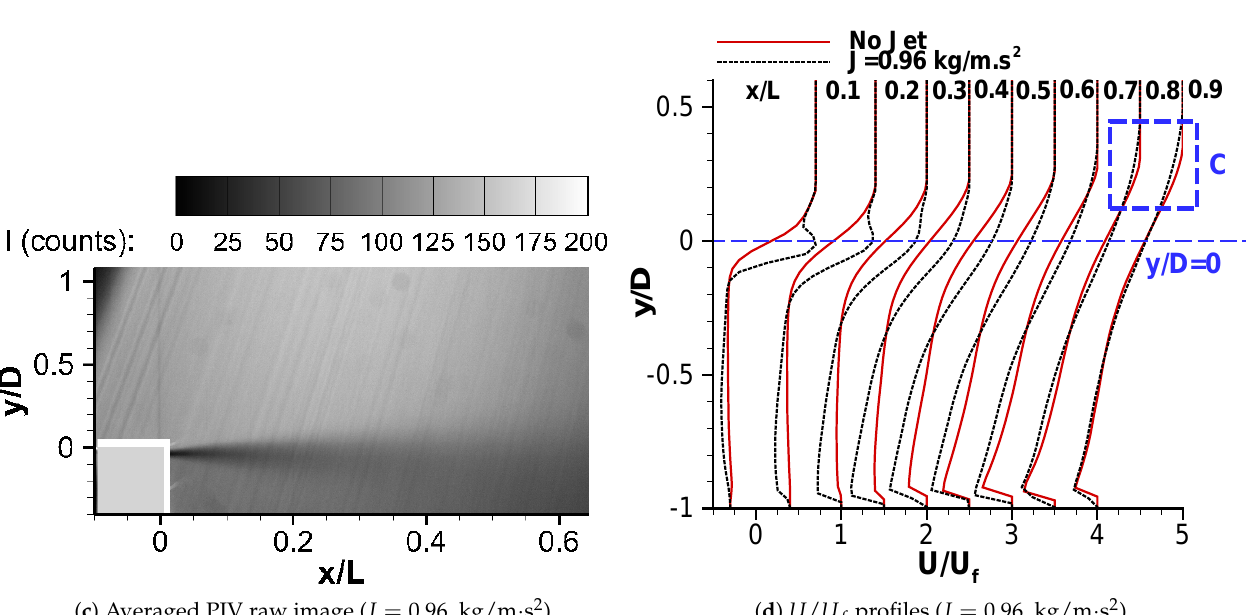
( c ) Averaged PIV raw image ( J = 0.96 kg/m · s 2 ) Figure 9. The time-averaged PIV raw images and the time-averaged U / U f profiles for Re D ≈ 50,000; sharp edge at LE; different J . C.S.S.L. denotes the cavity separated shear layer.